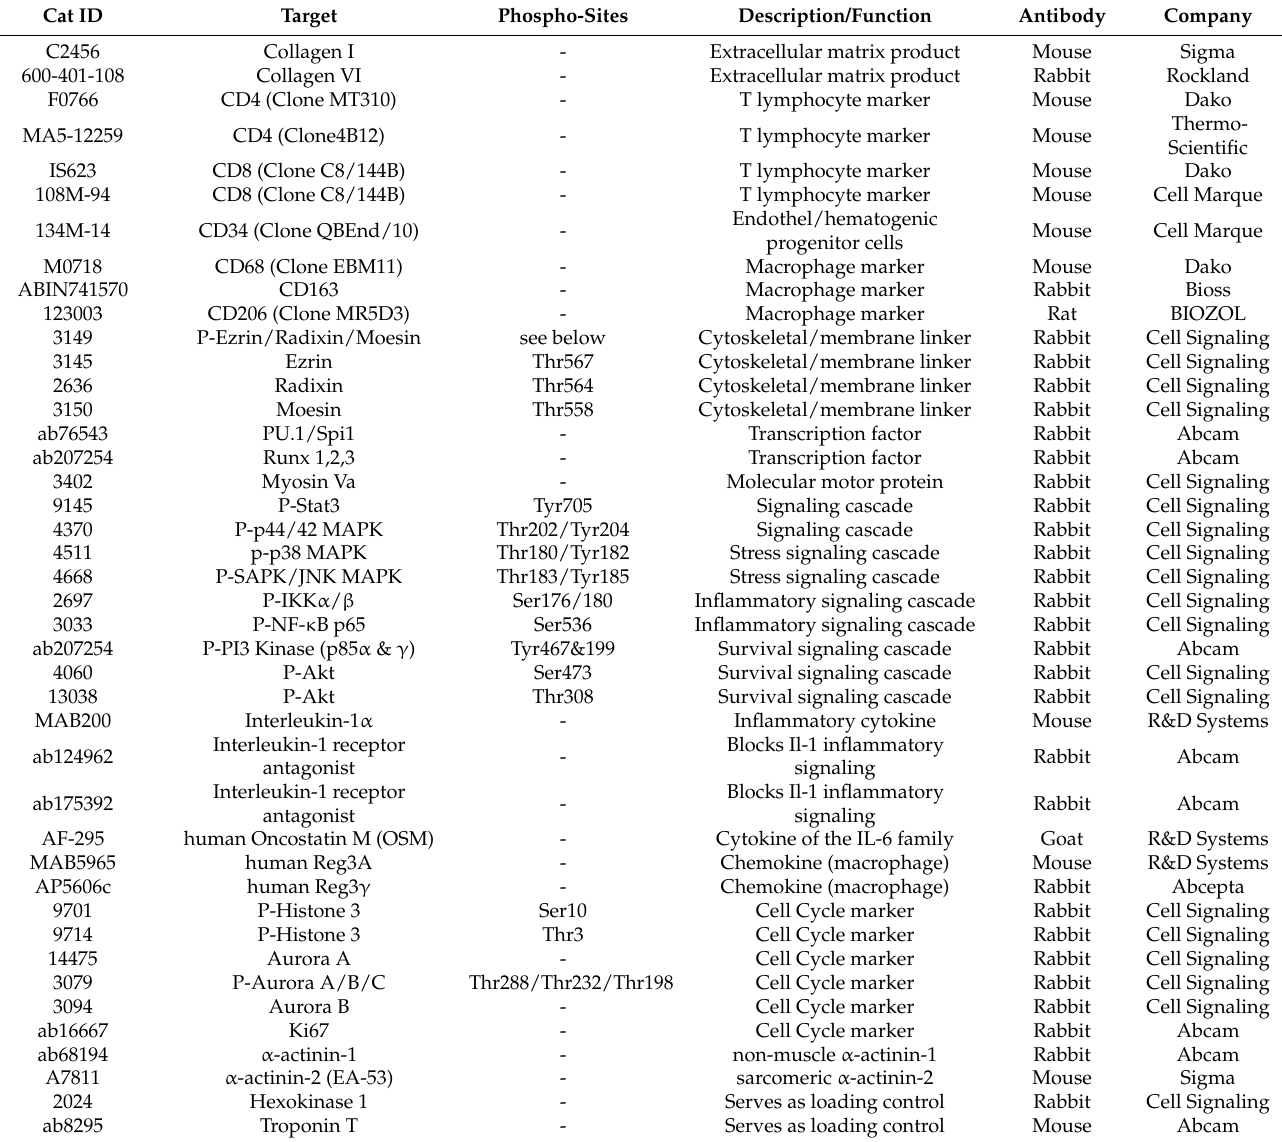
Table 2. List of antibodies and analyzed proteins. Catalog number (Cat ID), target of the antibody, phosphorylation site (phospho-sites), description/function, host, used abbreviations and distributing companies are